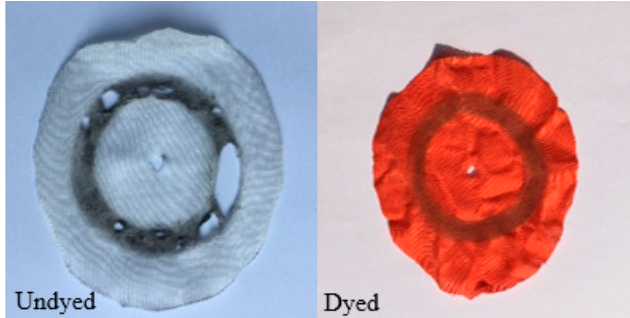
Figure 7. Abrasion resistance of undyed and dyed warp-knitted fabrics.